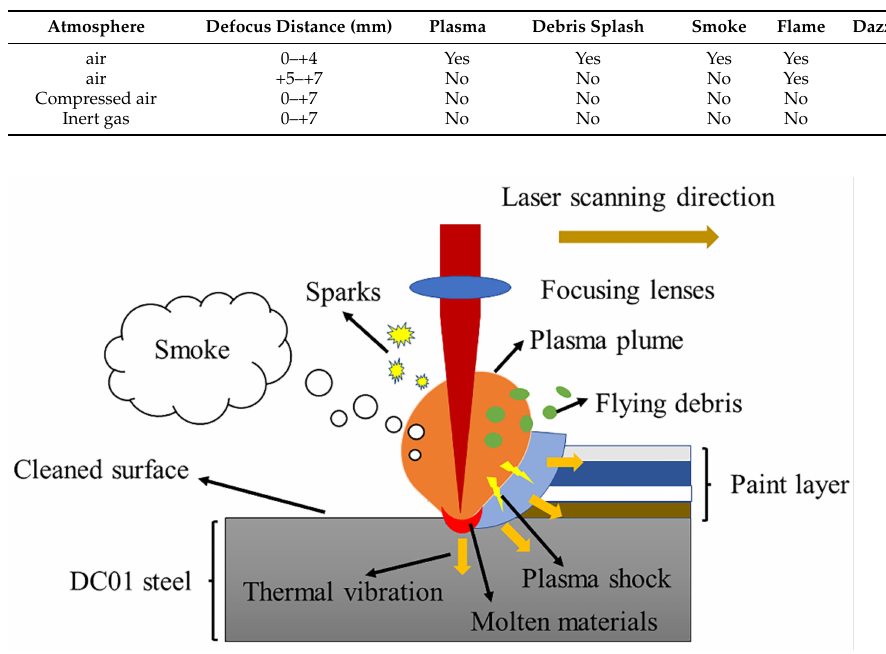
Figure 6. Schematic diagram of focused laser paint removal in ambient